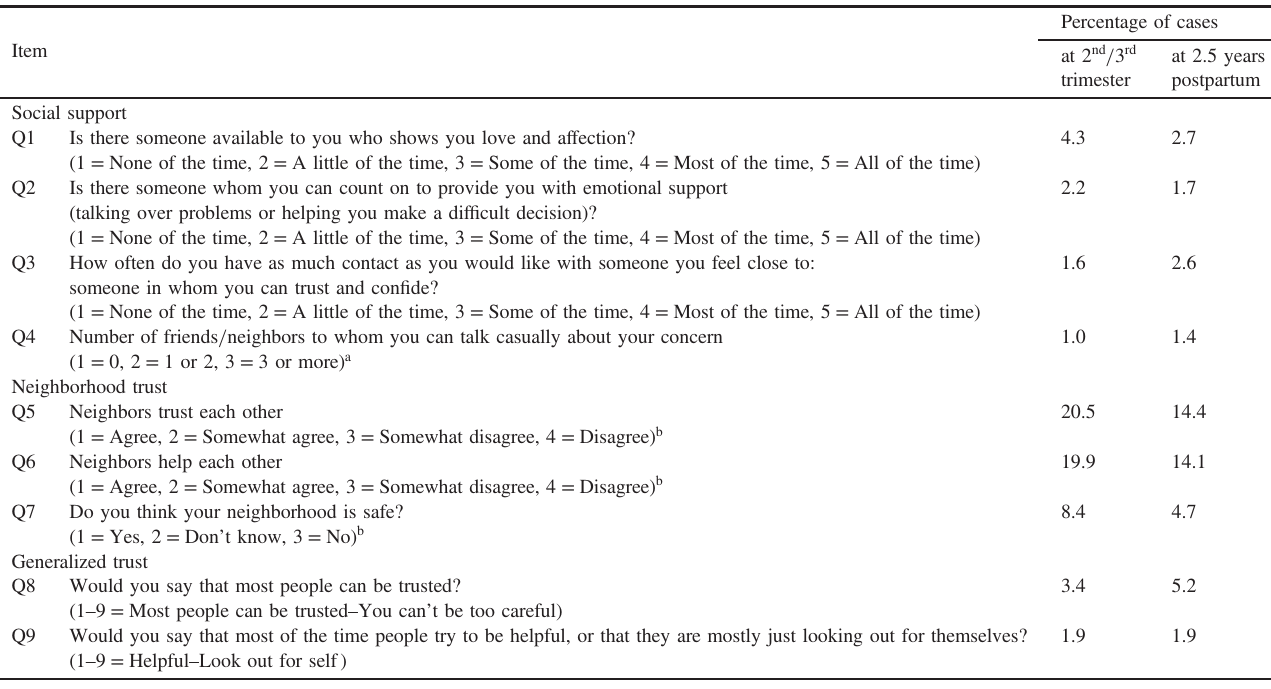
Table 1. The 9-item social support and trust questionnaire